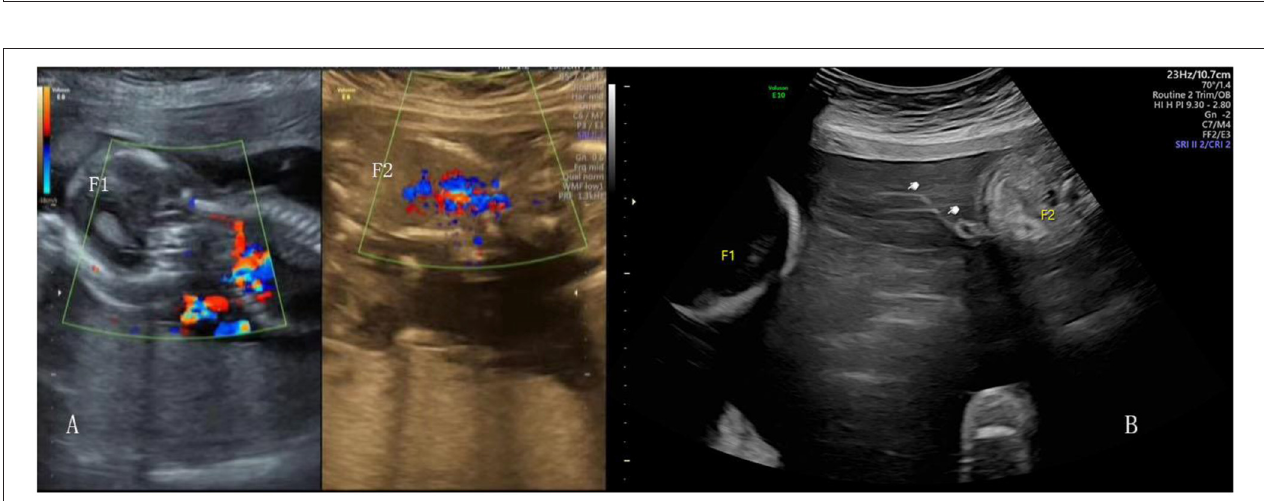
FIGURE 1 | Ultrasound image during the first trimester. At the 59th days of pregnancy, ultrasonography shows one gestational sac with three yolk sacs (A) . At 13 0/7 weeks of gestation, fetuses (A–C) are separated by intertwin membranes (arrow).